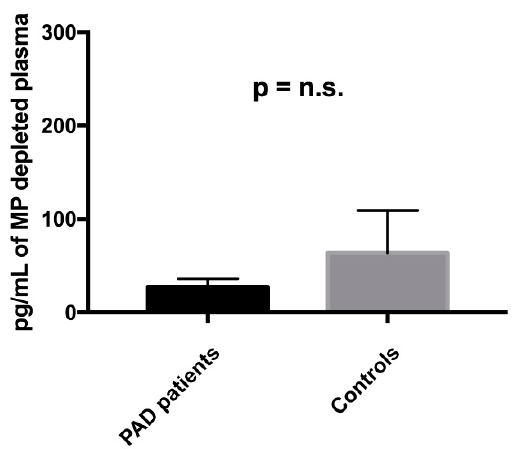
Figure 7. Levels of Shh protein in MP-depleted plasma of PAD patients and controls.